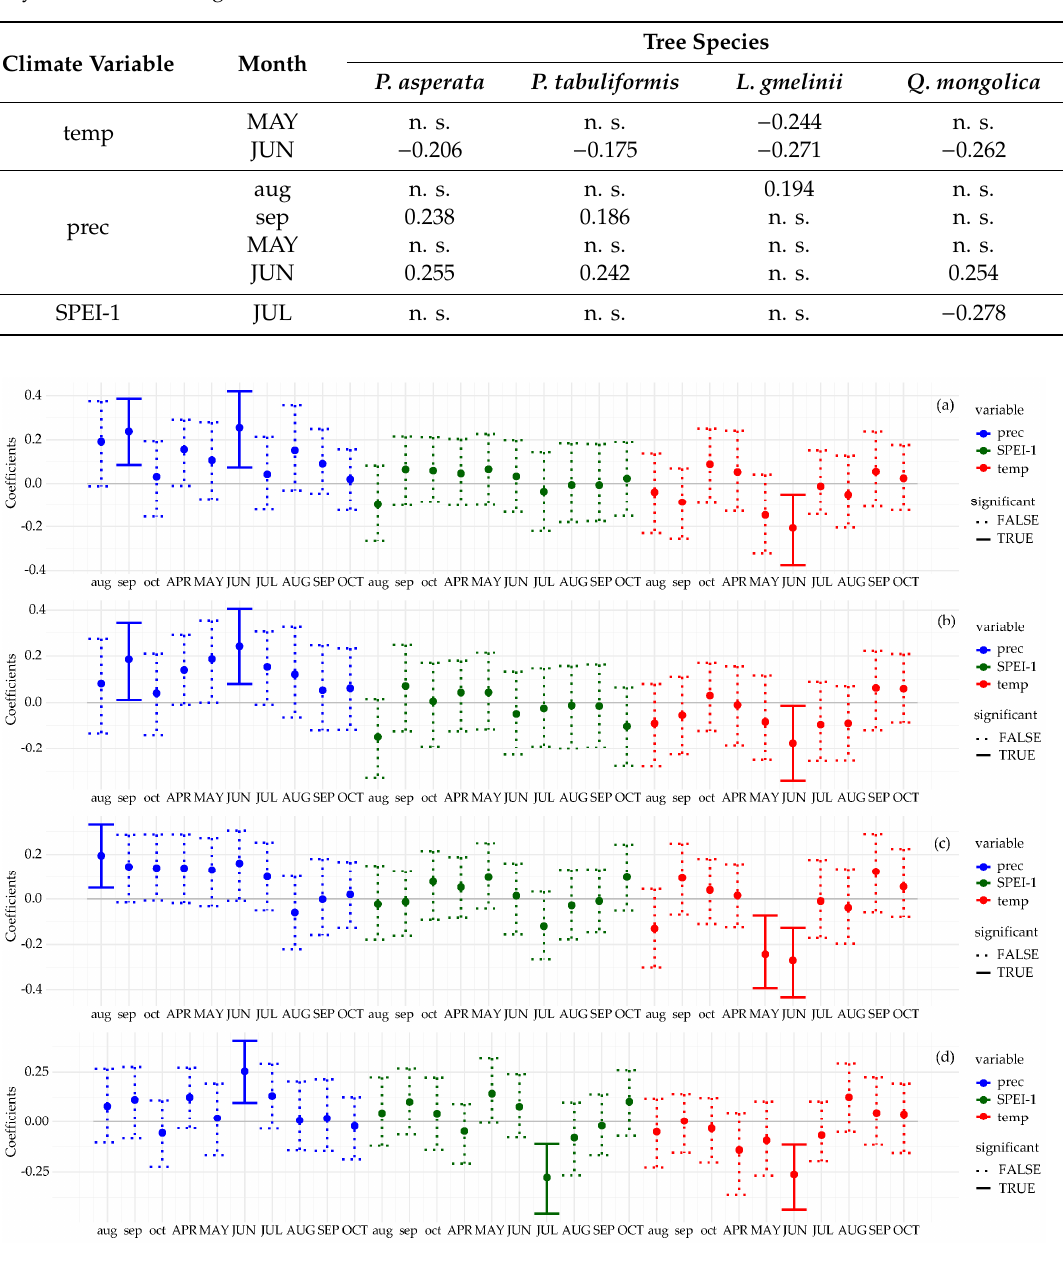
Figure 2. Response coefficients of mean monthly air temperature, monthly precipitation sums and SPEI-1 for the detrended ARI chronologies of P. asperata ( a ), P. tabuliformis ( b ), L. gmelinii ( c ) and Q. mongolica ( d ) (1925–2013). Small letters represent the months of the preceding year and capital letters represent the months of the current year. The darker bars indicate a coefficient significant at p < 0.05, the lines represent the 95%-confidence interval.